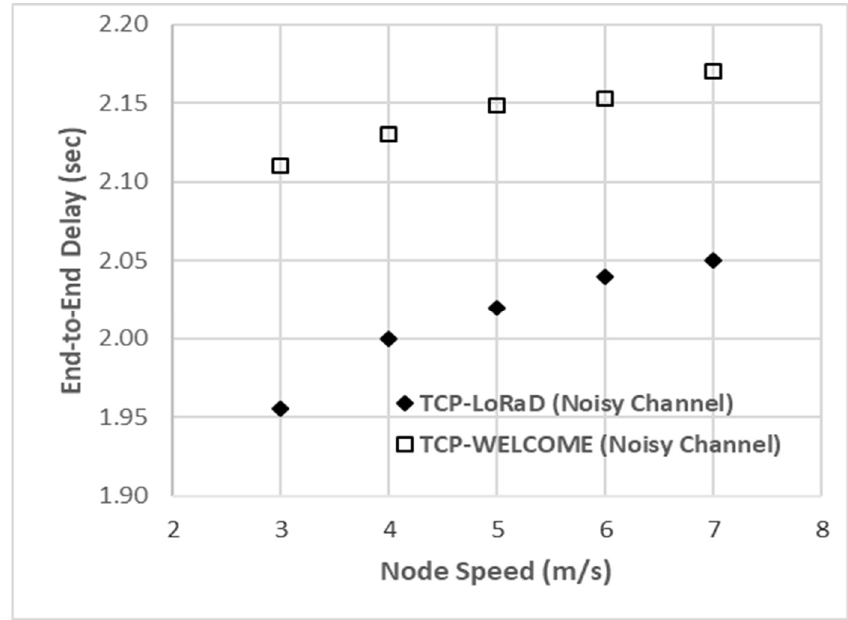
Figure 10. End-to-End delay versus node speed. Comparison of TCP-LoRaD and TCP-WELCOME.